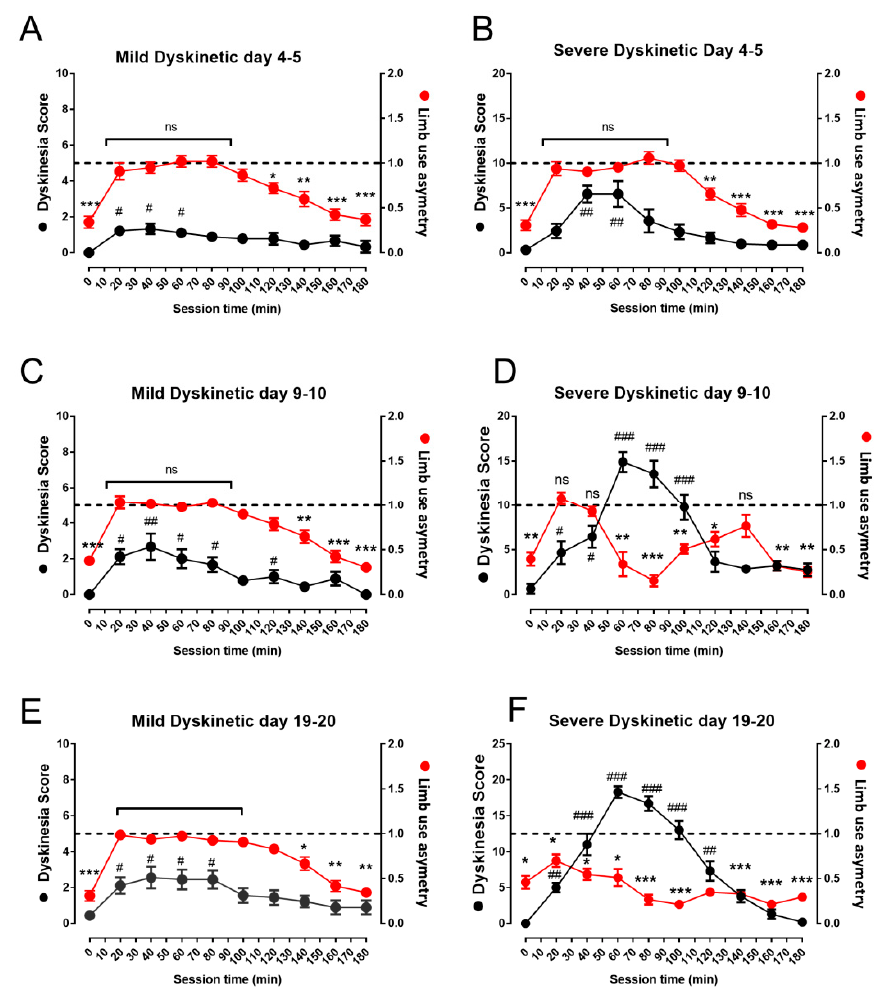
Figure 2. Comparison of the therapeutic response to L-DOPA measured by the limb asymmetry index and AIMs scores in mildly and severely dyskinetic animals classified at the end of L-DOPA treatment. ( A , C , E ) Graphs show the temporal course of the limb asymmetry index (right axes) and AIMs scores (left axes) during two continuous behavioral (180-min) evaluation sessions of a single dose of L-DOPA in mildly dyskinetic rats. ( B , D , F ) The e ff ect on these same days in a set of severely dyskinetic rats. Data represent mean ± standard error of eight mildly dyskinetic vs. nine severely dyskinetic animals. Note: ns = significant di ff erences, * p < 0.05, ** p < 0.01, and *** p < 0.001, between the value of the asymmetry index compared to 1; # p < 0.05, ## p < 0.01, and ### p < 0.001, with respect to initial score of dyskinesia.